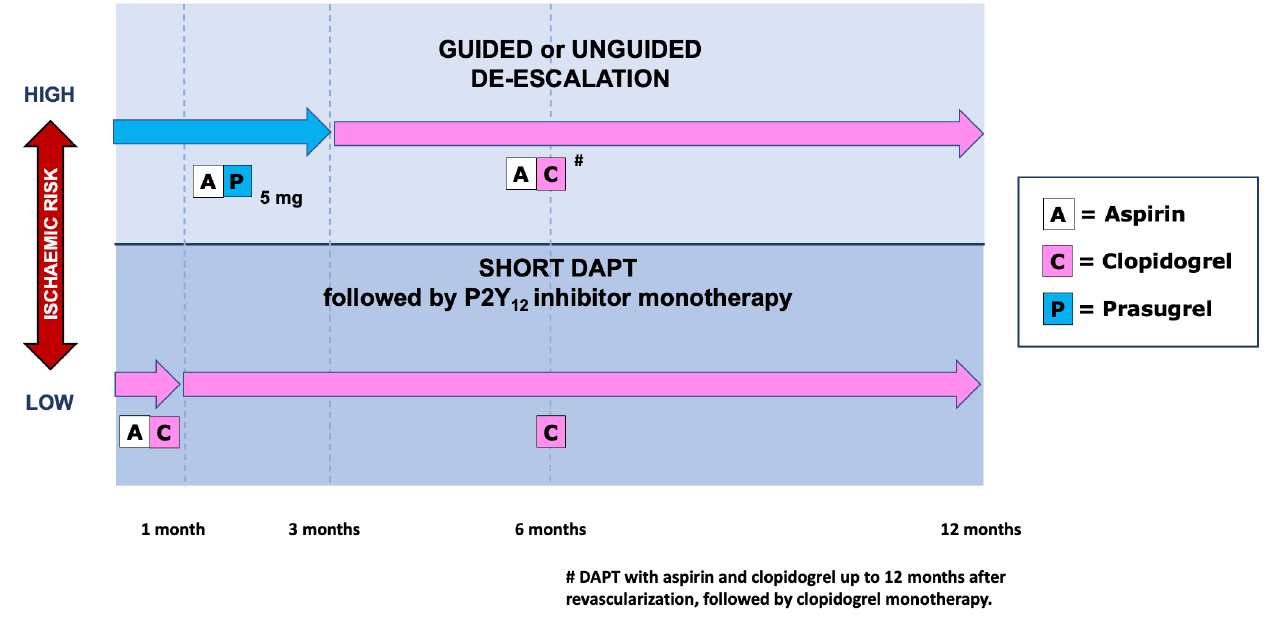
Figure 1. Algorithm for antithrombotic treatment strategies in elderly patients with acute coronary syndrome stratified by ischaemic risk. Abbreviations: DAPT, dual antiplatelet therapy.